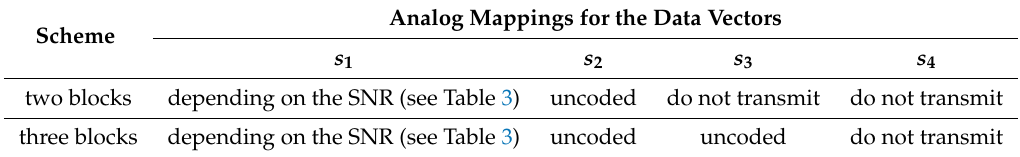
Table 2. Analog transmission schemes.